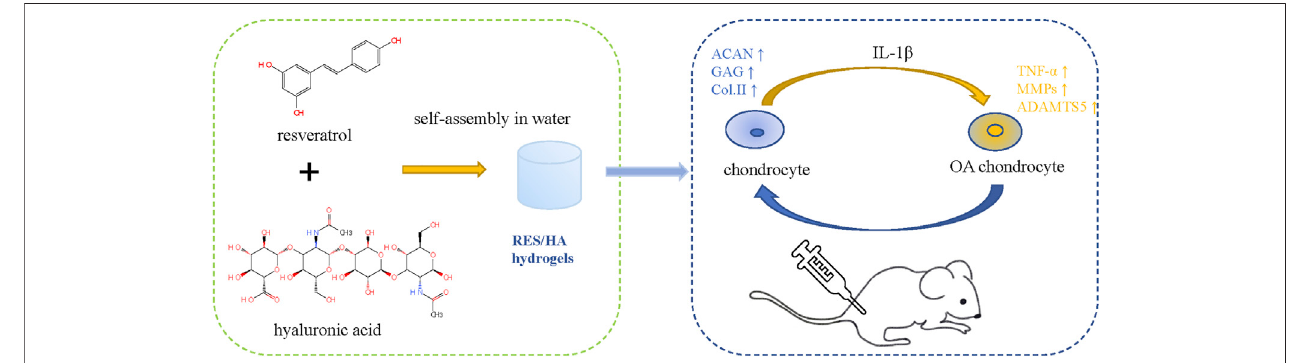
FIGURE 2 | Schematic diagram of chondrocyte regulation of HA-based hydrogel combined with BDEs.